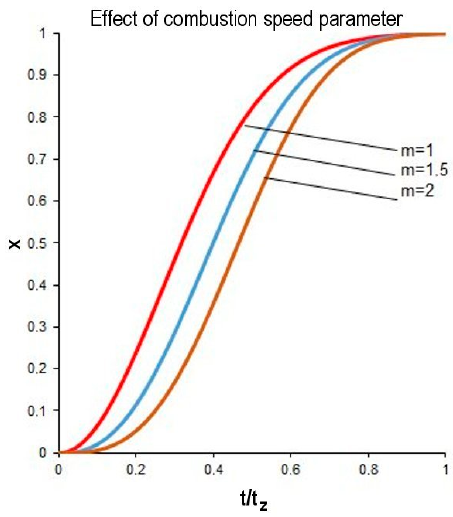
Figure 7. E ff ect of combustion speed parameter on heat release shape of Wankel engine for di ff erent engine